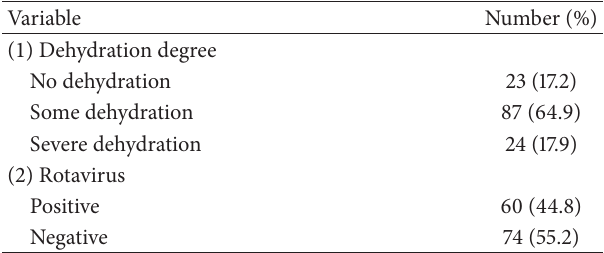
Table 2: Dehydration degree and rotavirus in infants ≤ 6 months of age.